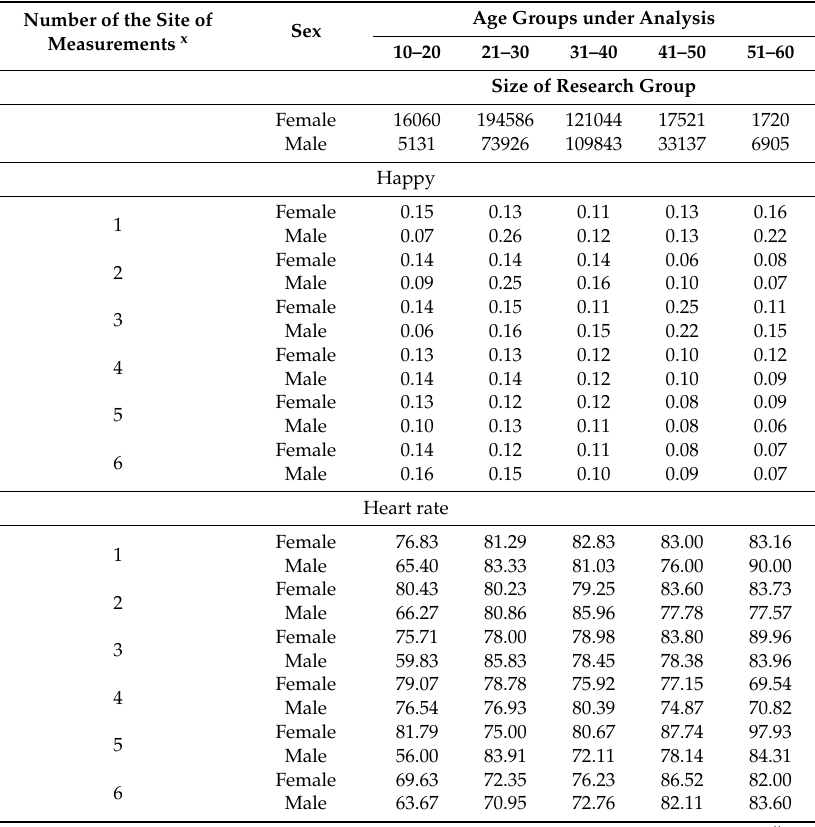
Table 2. Human emotion